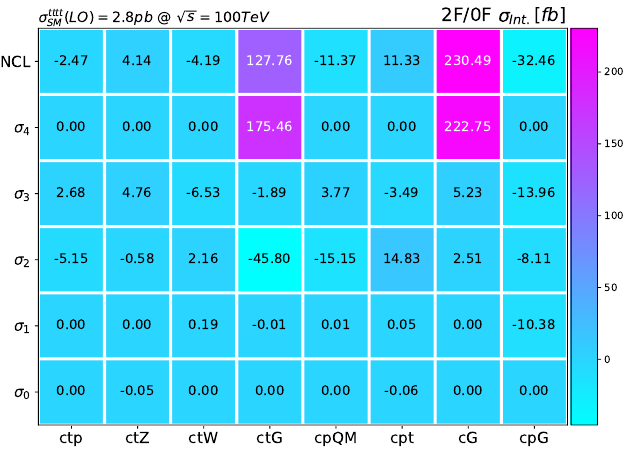
Figure 8 . Same as figure 7 but for the 2-heavy 2-light operators.